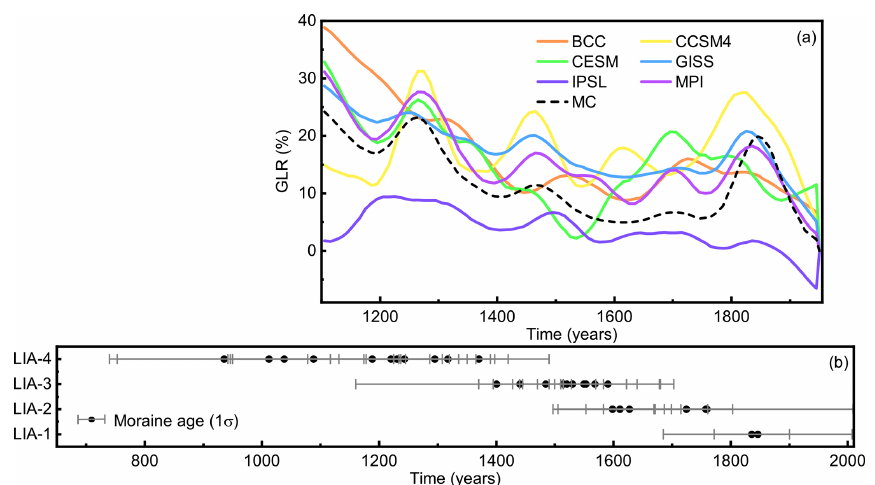
Figure 4. (a) Time series of regional average GLR from 1100 to 1950CE. (b) The observational timing when glaciers in the monsoonal Himalaya reached their maximum peak GLR. We grouped the moraine ages based on their temporal distances to each glacial substage simulated in the MC experiment. Detailed information on the moraine ages measured by 10 Be and 14 C can be found in Table S1 and Xu and Yi (2014), respectively.